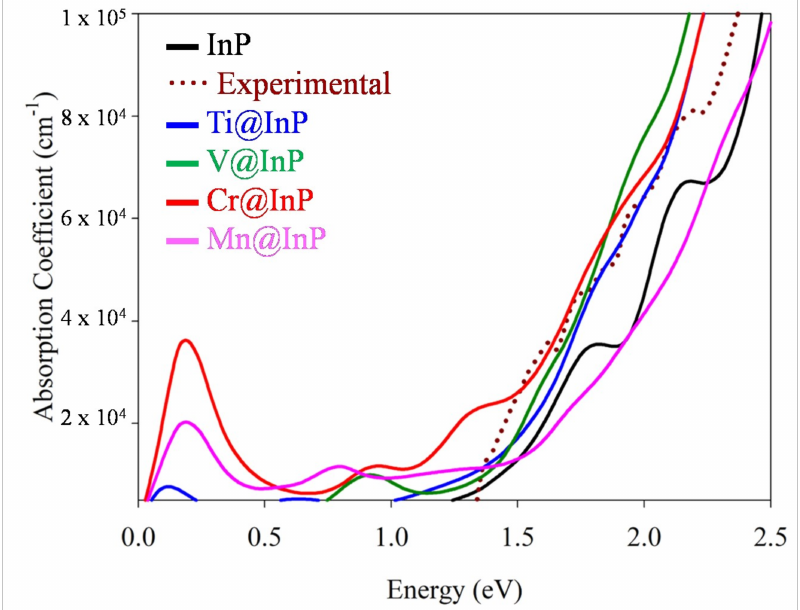
Figure 7. Absorption coe ffi cients for InP and TM@InP (TM = Ti, V, Cr, Mn) compounds, along with experimental data for InP (taken from reference